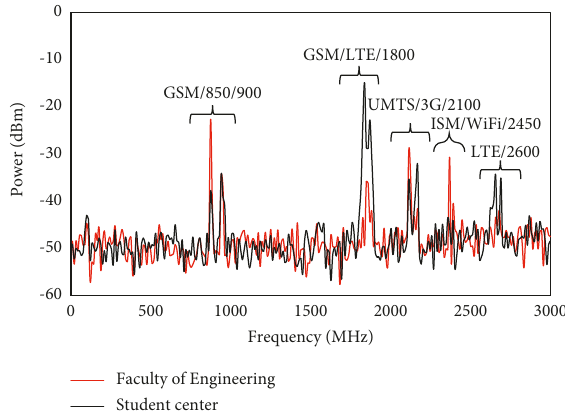
Figure 1: Evaluation of the received RF ambient power